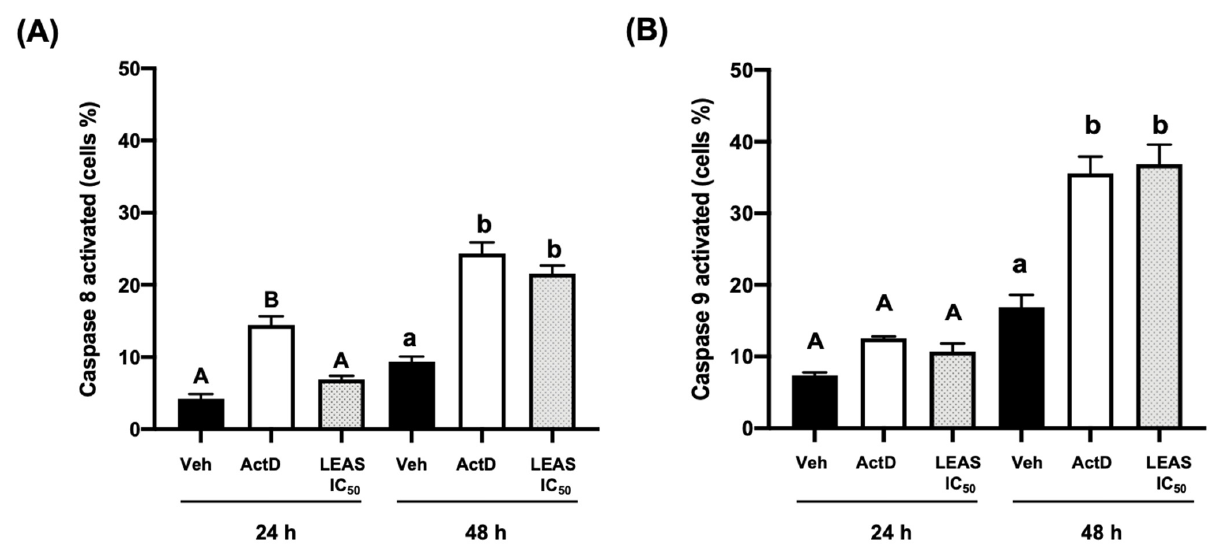
Figure 4. Caspase-8 and caspase-9 activation by LEAS in D-17 cells . Cells treated with LEAS IC 50 (15.5 µg/mL) for 24 h and 48 h were analyzed by flow cytometry to caspase-8 ( A ) and caspase-9 activation ( B ). Representative plots are shown. The graphic shows percentage of cells with caspase-activated for each time of treatment. Each bar shows the mean of triplicates ± SE of two independent experiments. Different letters denote significant differences within the treatments at the time evaluated (one-way ANOVA and Tukey’s pairwise comparison, p < 0.05). ActD = Actinomycin D (80 µg/mL). Veh = vehicle (DMSO 0.1%).